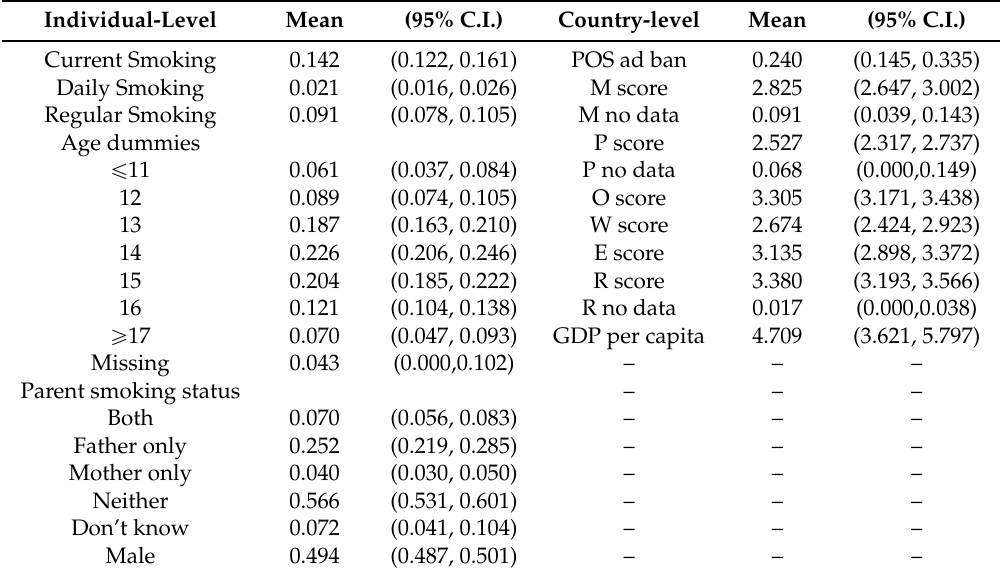
Table 2. Weighted summary statistics ( N = 569,853).